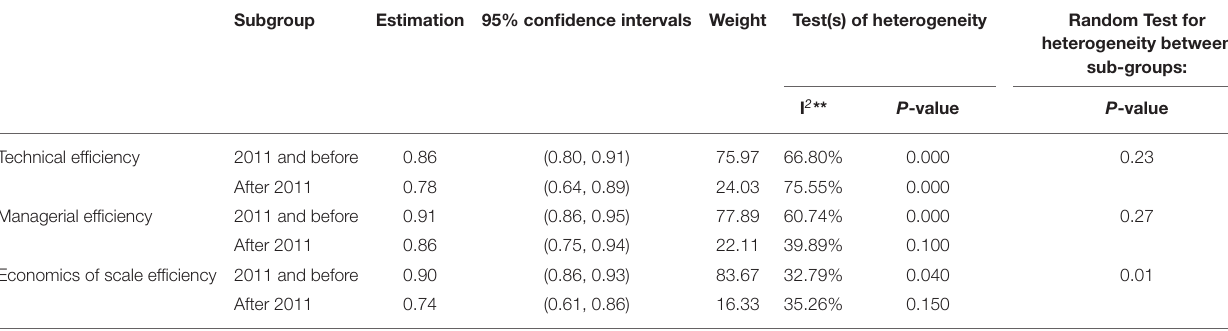
TABLE 6 | The random pool estimation of technical, managerial, and economics of scale efficiencies among Iranian hospitals by time of studies. Subgroup Estimation 95% confidence intervals Weight Test(s) of